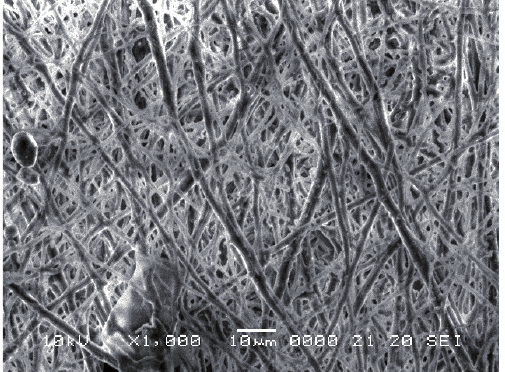
F 10: SEM micrograph receptor loaded eggshell